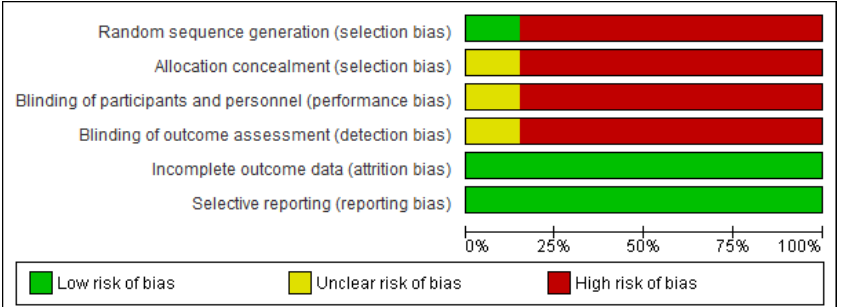
Figure 3. Risk of bias graph: review authors’ judgements about each risk of bias item presented as percentages across all included studies.